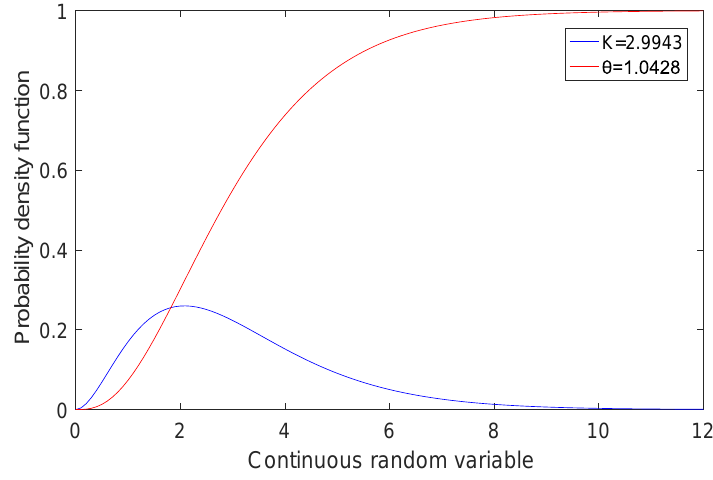
Figure 5. Schematic diagram of scatter gamma distribution of normal